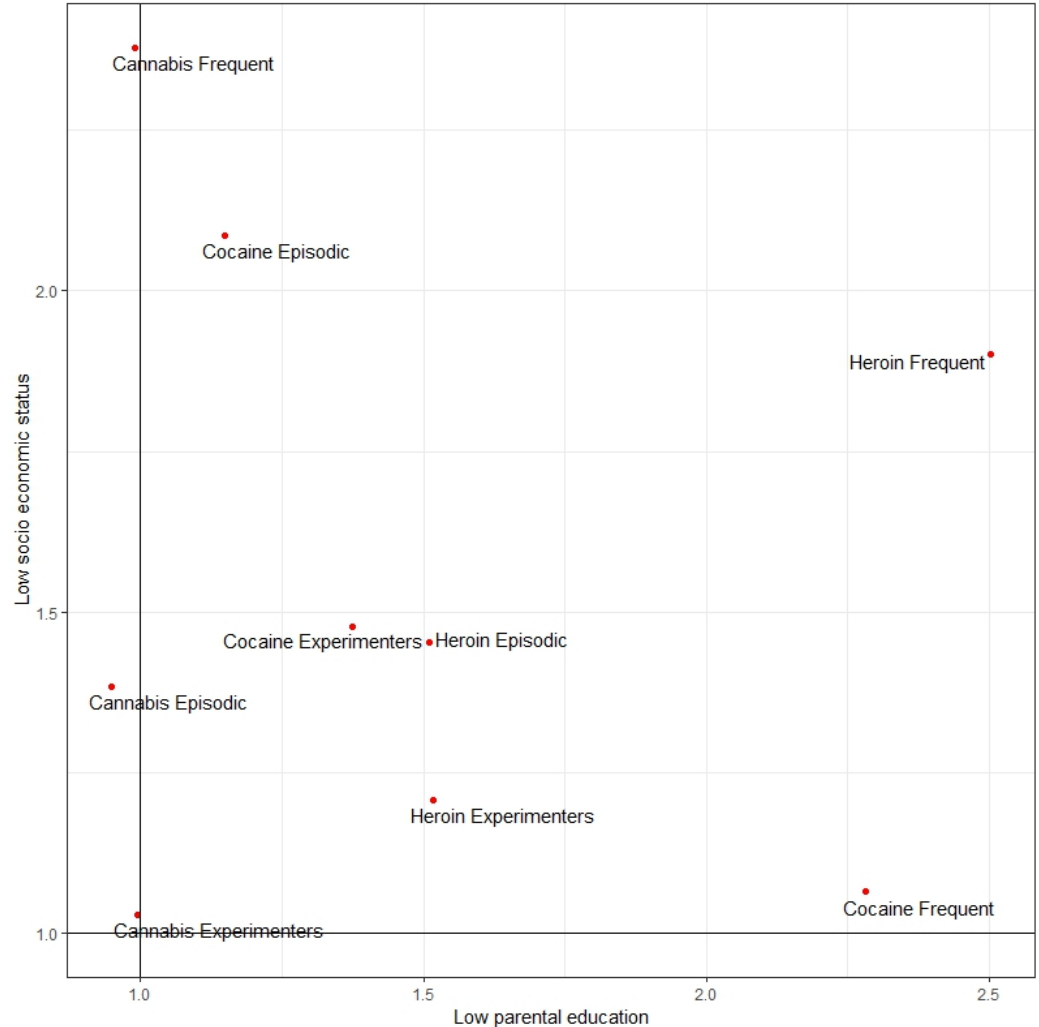
Figure 4. Quadrant analysis with adjusted Odds Ratios (aOR) for low socioeconomic status and low parental education with model A. Authors’ elaboration on ESPAD data. Note: upper right quadrant = low socioeconomic status and low parental education; bottom right quadrant = high socioeconomic status and low parental education; bottom left quadrant = high socioeconomic status and high parental education; upper left quadrant = low socioeconomic status and high parental education. The majority of drug-use patterns are concentrated in the upper right quadrant. On the contrary, none of them is located either in the bottom left quadrant or in the bottom right quadrant.